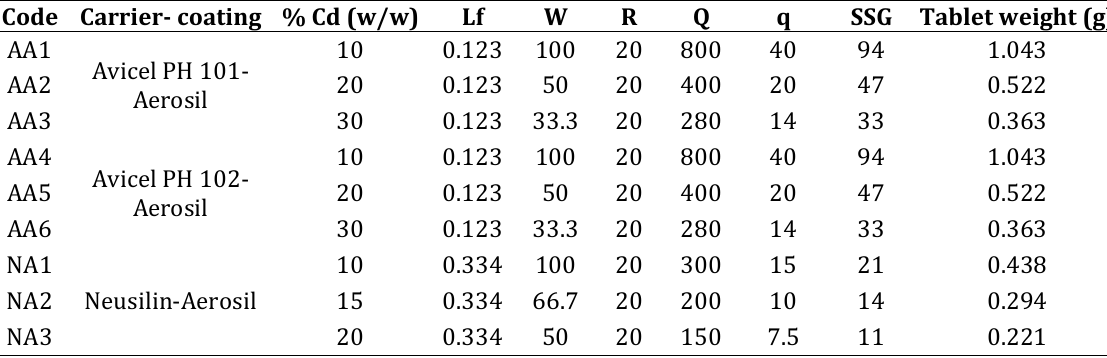
Table I. Composition of liquisolid tablets with 10mg of atorvastatin calcium. Code Carrier- coating % Cd